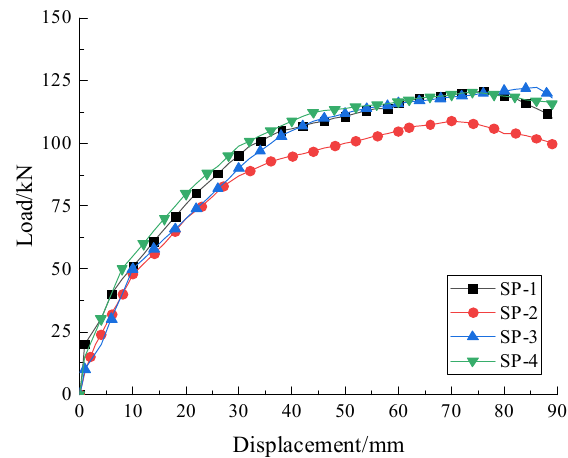
Figure 8. Load-deflection curves of